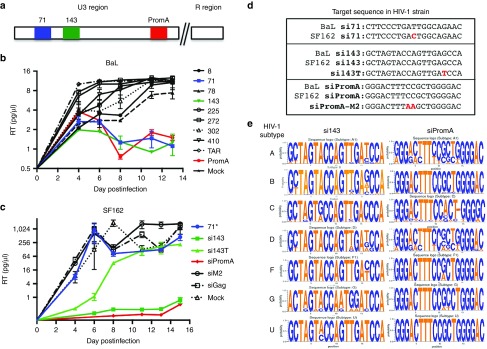
Novel candidate siRNAs targeting the HIV-1 5′LTR region. (a) The regions within HIV-1 5′LTR targeted by 71, 143, and PromA siRNAs are highlighted in blue, green, orange, and red, respectively. (b) Effect of siRNAs on the time course of HIV-1BaL production in MAGIC-5 cells (HeLa cells stably transfected with CD4, CCR5, and CXCR4). (c) Effect of siRNAs on the time course of HIV-1SF162 production in HeLa T4+ cells. 5 × 104 MAGIC-5 cells or HeLa-T4+ cells were transfected with 80 pmol/l of the appropriate siRNA, then infected using HIV-1BaL (100 pg of RT/μl) or HIV-1SF162 (140 pg of RT/μl), respectively. Supernatants were harvested and virus production assessed using levels of RT activity. SiRNAs 71 (blue) and143 (dark green) profoundly suppressed HIV-1BaL production for >12 days and at levels comparable to the current lead candidate, PromA (red), while only siRNA 143 (dark green) suppressed HIV-1SF162 production for >14 days to similar levels. Asterisk indicates a single mismatch in siRNA 71 target sequence of HIV-1SF162. (d) Subtype B HIV-1BaL and HIV-1SF162 sequence alignment at targets of lead siRNA candidates. (e) Consensus sequence alignments of siRNAs 143 and PromA across HIV-1 subtypes A, B, C, D, F, G, and U. The 305 HIV-1 subtype sequences analyzed were obtained using QuickAlign Analysis from the Los Alamos National Laboratory HIV sequence database, which then generated the WebLogo 3 sequence logos32,33 and show both siRNAs target relatively conserved regions across HIV-1 subtypes. Gaps are indicated by dashes. The sequence logos display a graphical representation of the consensus sequence within a multiple sequence alignment of each HIV-1 subtype, with the stack height indicating sequence conservation at that position and the symbol height within the stack indicating relative nucleic acid frequency.32,33